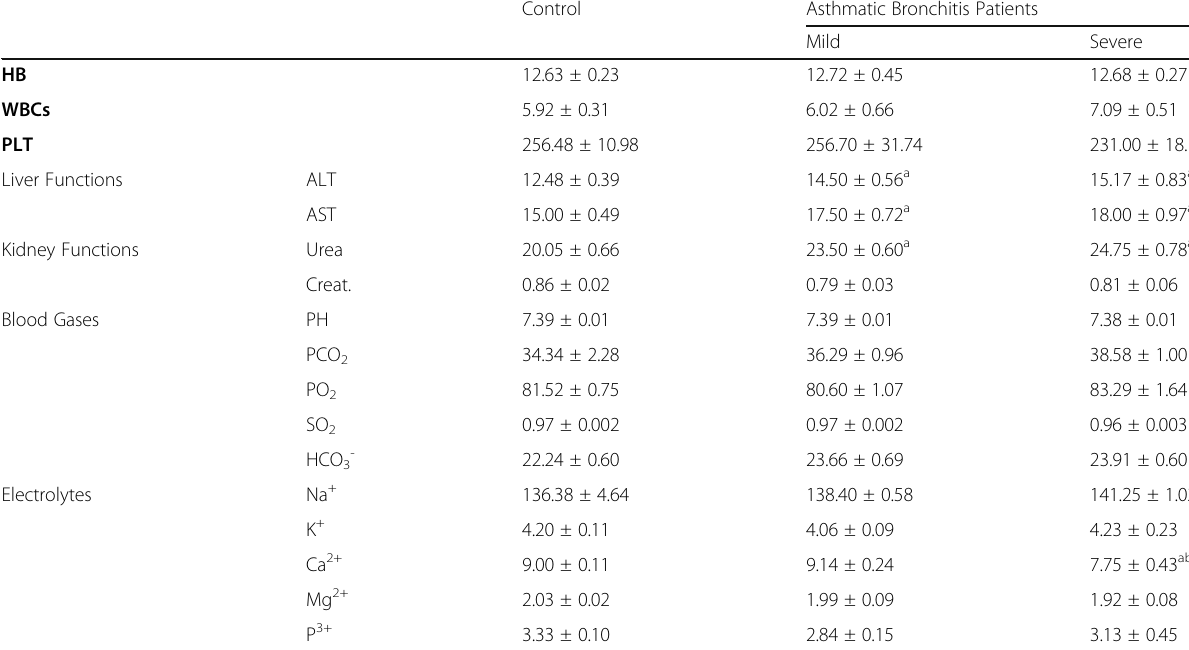
Table 1 Statistical significance of major blood components (hemoglobin (HB), white blood cells (WBCs) and platelets (PLT)), liver and kidney functions, blood gases and electrolytes showing the differences between asthmatic bronchitis patients at mild and severe stages as compared to control